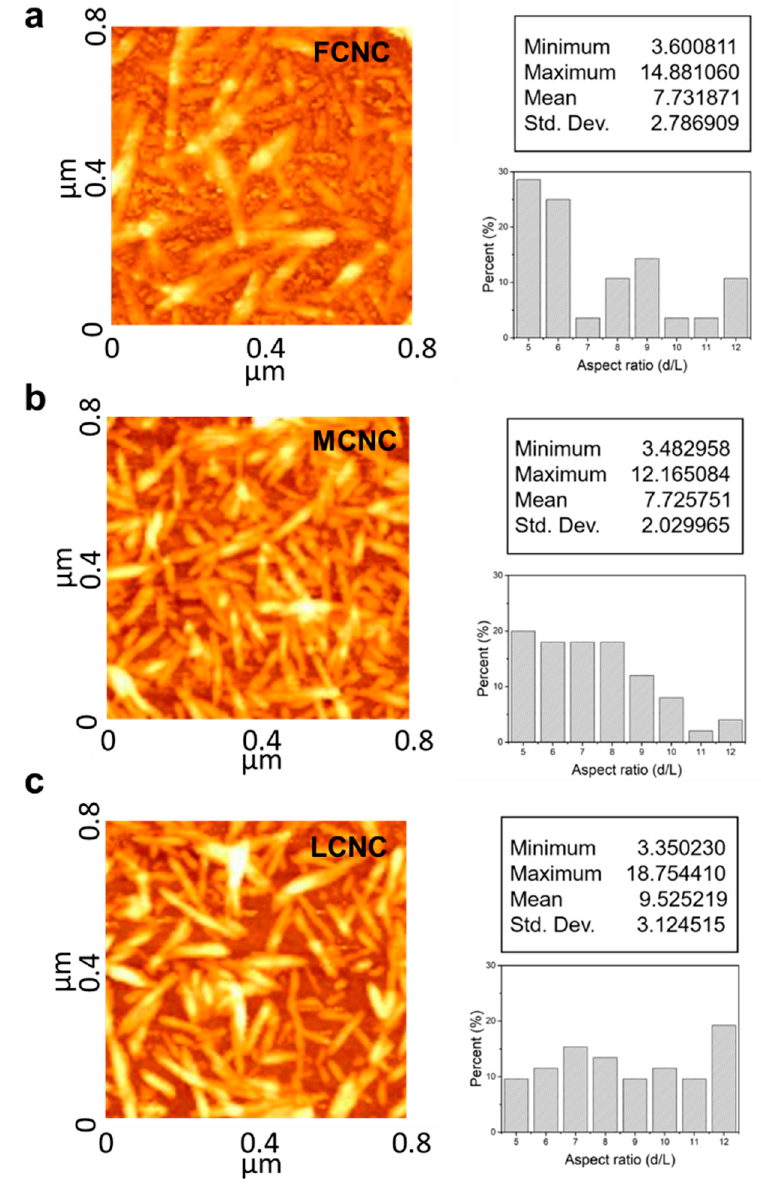
Figure 2. AFM topographic images (on the left) and histograms of the aspect ratio (on the right) from various CNC sources. AFM image shows that the majority of individual CNCs are well dispersed, which provide a direct comparison in nanoscale. ( a ) FCNC, ( b ) MCNC, and ( c ) LCNC. I 200 − I amorphous CI = I 200